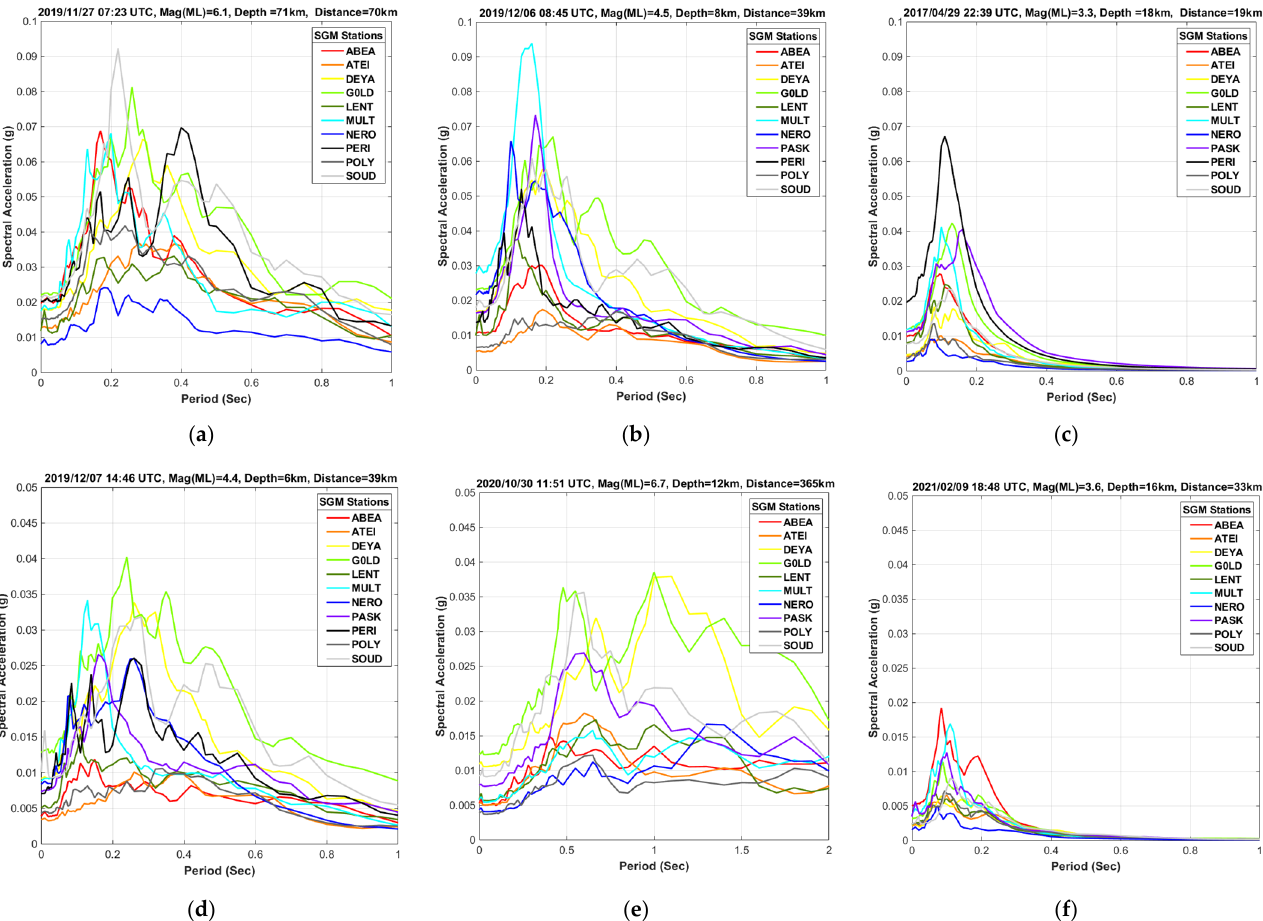
Figure 2. Spectral acceleration in g-units for the strongest events since 2017: ( a ) EQ.3; ( b ) EQ.4; ( c ) EQ.1; ( d ) EQ.5; ( e ) EQ.7 (Samos event); ( f ) EQ.8.